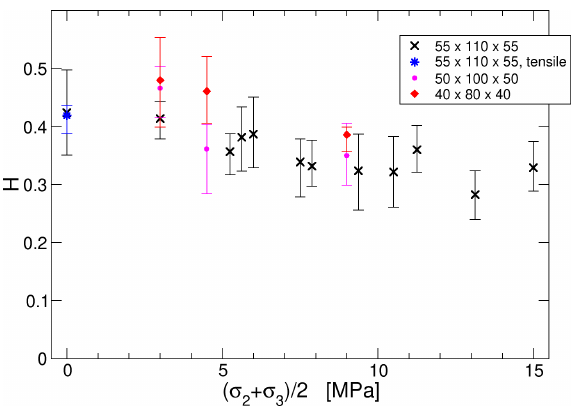
Figure 11. Average and variability of Hurst exponents for surfaces generated with different average confining stress (σ 2 + σ 3 )/ 2. Black: triaxial compression models, this work, blue: unconfined extension models, this work, red and pink: triaxial compression models; data are from Ohagen (2019). Error bars show top and bottom quartiles.